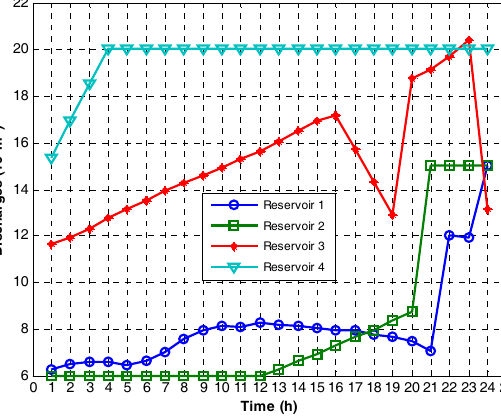
Figure 3. Hourly hydro discharges volumes of the optimal solution for test system 1, case1.